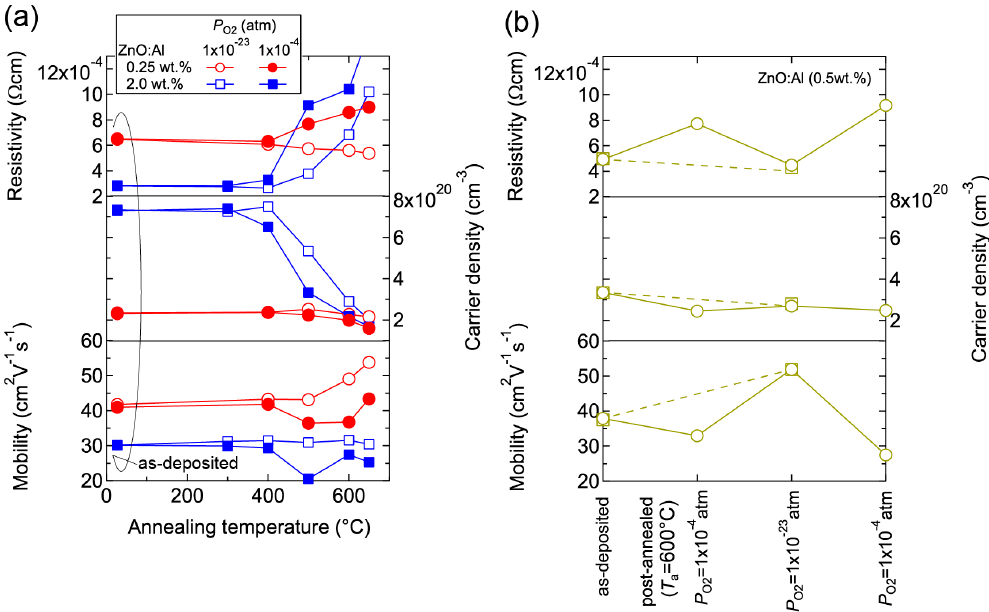
Figure 10. Room-temperature resistivity, carrier density, and mobility in ( a ) ZnO:Al (0.25 and 2.0 wt %) films plotted as a function of annealing temperature at P O2 values of 1 × 10 − 23 and 1 × 10 − 4 atm and ( b ) two ZnO:Al (0.5 wt %) films post-annealed at 600 °C under various P O2 values.